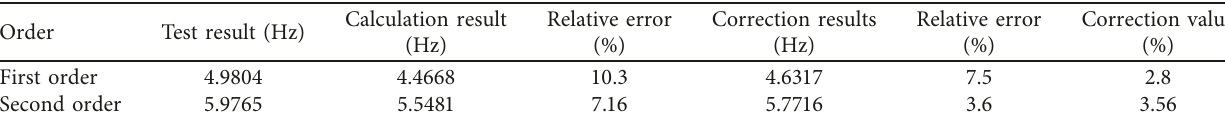
Table 7: Comparison of corrected